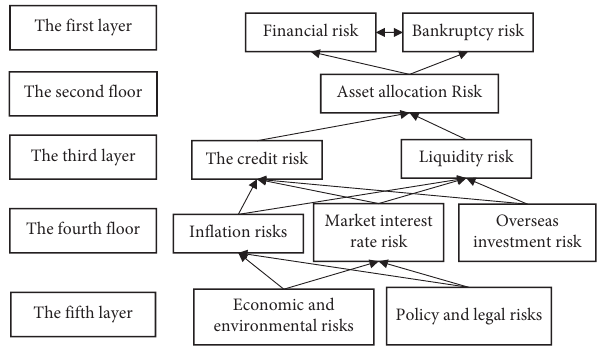
Figure 2: Optimization hierarchy.